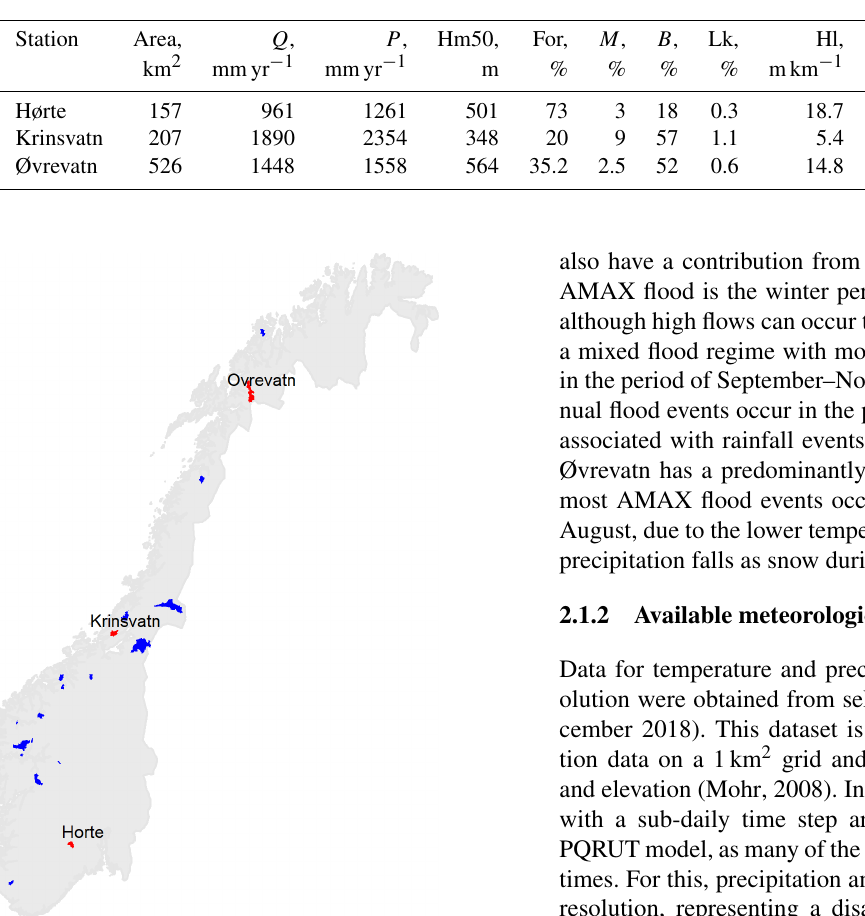
Table 1. Properties for the selected catchments, including catchment area (Area), mean annual streamflow ( Q ), mean annual precipitation ( P ), mean elevation (Hm50), percent forest (For), percent marsh ( M ), percent sparse vegetation over the treeline ( B ), catchment steepness (Hl), effective lake percent (Lk) and mean annual temperature (Temp).